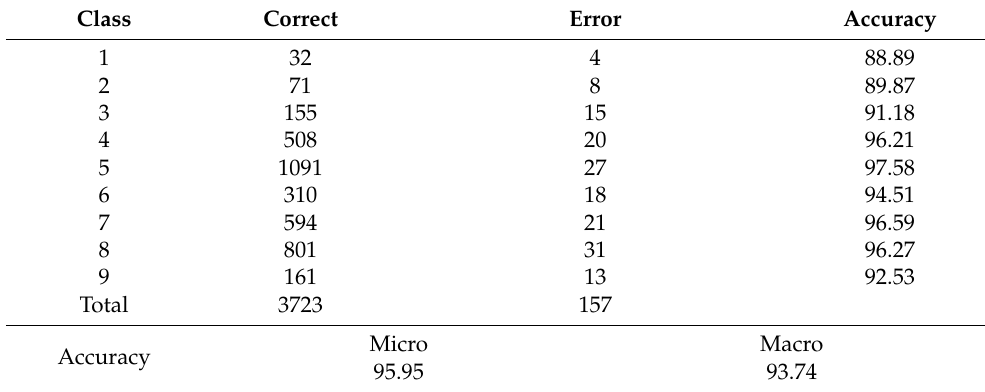
Table 5. Performance for each label measured in Task 3 of sentence prediction.